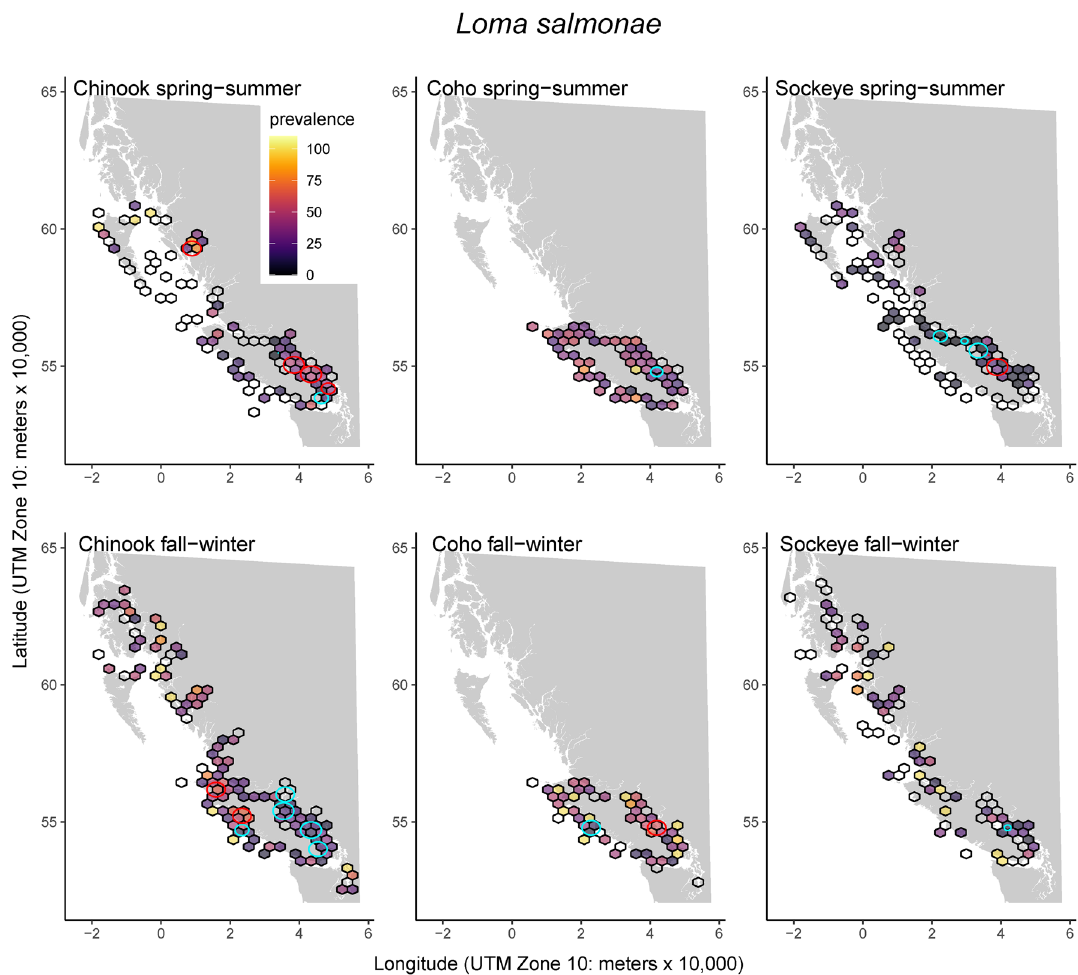
Figure 1. Infection clusters for the marine-transmitted microsporidian, Loma salmonae , occurred for all host species but prevalence was greatest in Coho salmon. The color of 30 km hexagons indicates L. salmonae prevalence while empty cells indicate that samples were collected but the pathogen was not detected (0% prevalence). Red circles indicate positive clusters (significantly higher than random likelihood of infection or infection intensity). Blue circles indicate significantly lower than expected regions of infection. Similar maps for 40 other pathogen taxa are available in Supplementary Material 1. Basemap data are from the GSHHG (Global Self-consistent, Hierarchical, High-resolution Geography) Database 38 . The coordinate system for the data is WGS 1984 and the maps are projected in NAD